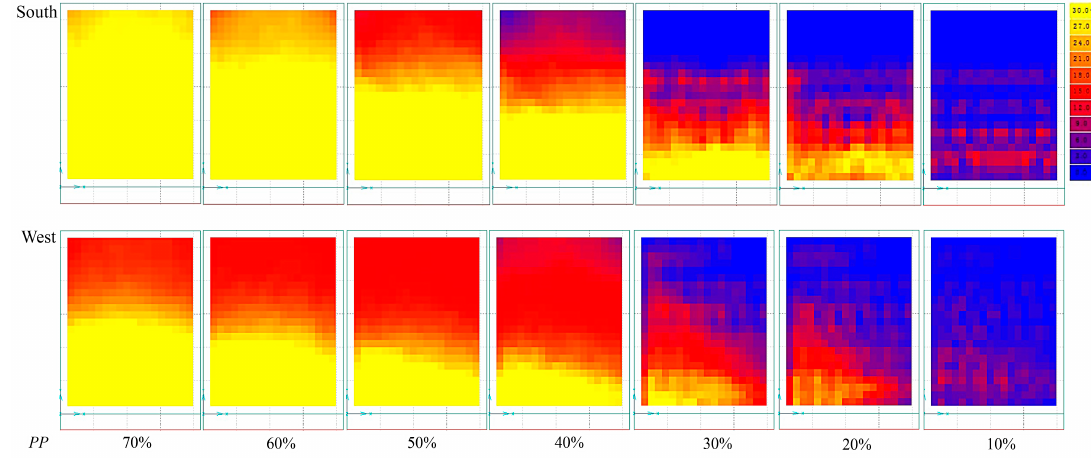
Figure 7. Distribution of over-day lit area in Group 1.